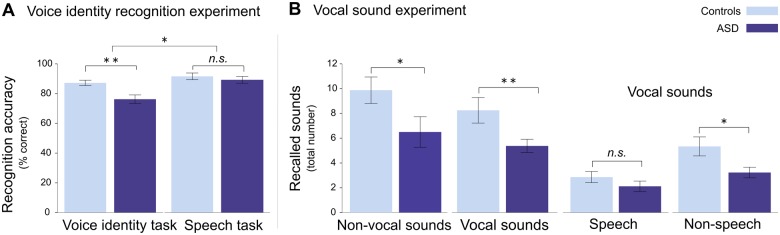
 Behavioural results from the two fMRI experiments (see also Table 2 and Supplementary Table S3). (A) Performance accuracy in the voice identity recognition experiment: The ASD group performed significantly worse than the control group in the voice identity task. There were no significant differences between the ASD and the control group in the speech task. (B) Total amount of recalled sounds after the vocal sound experiment. The ASD group recalled significantly less non-vocal and vocal sounds than the control group. The vocal sound condition contained both speech and non-speech sounds. The ASD group recalled a comparable number of speech sounds but less non-speech sounds as compared to the control group. Error bars represent± 1 SE; *P < 0.05; **P < 0.005; n.s. not significant.